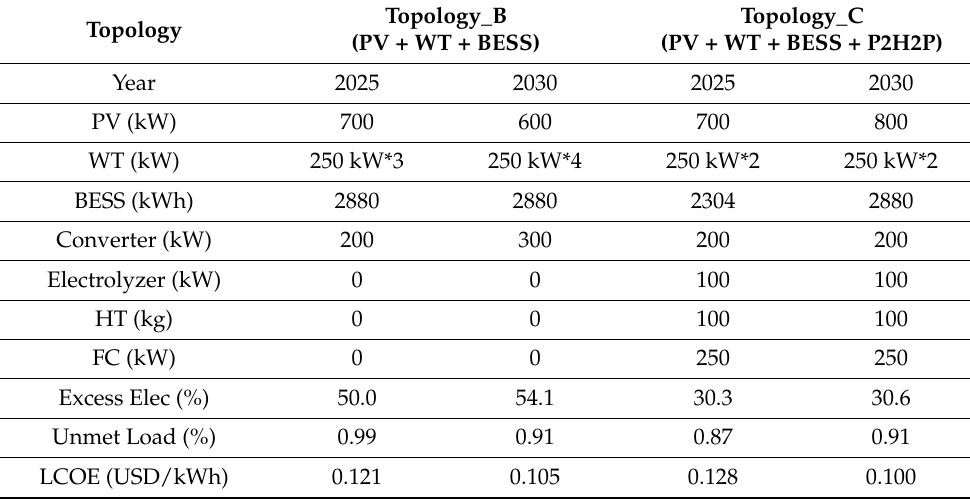
Table 18. Simulation result by